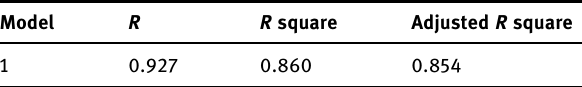
Table 3: Model summary for weekends ( Saturday, Sunday 2019 ) Model